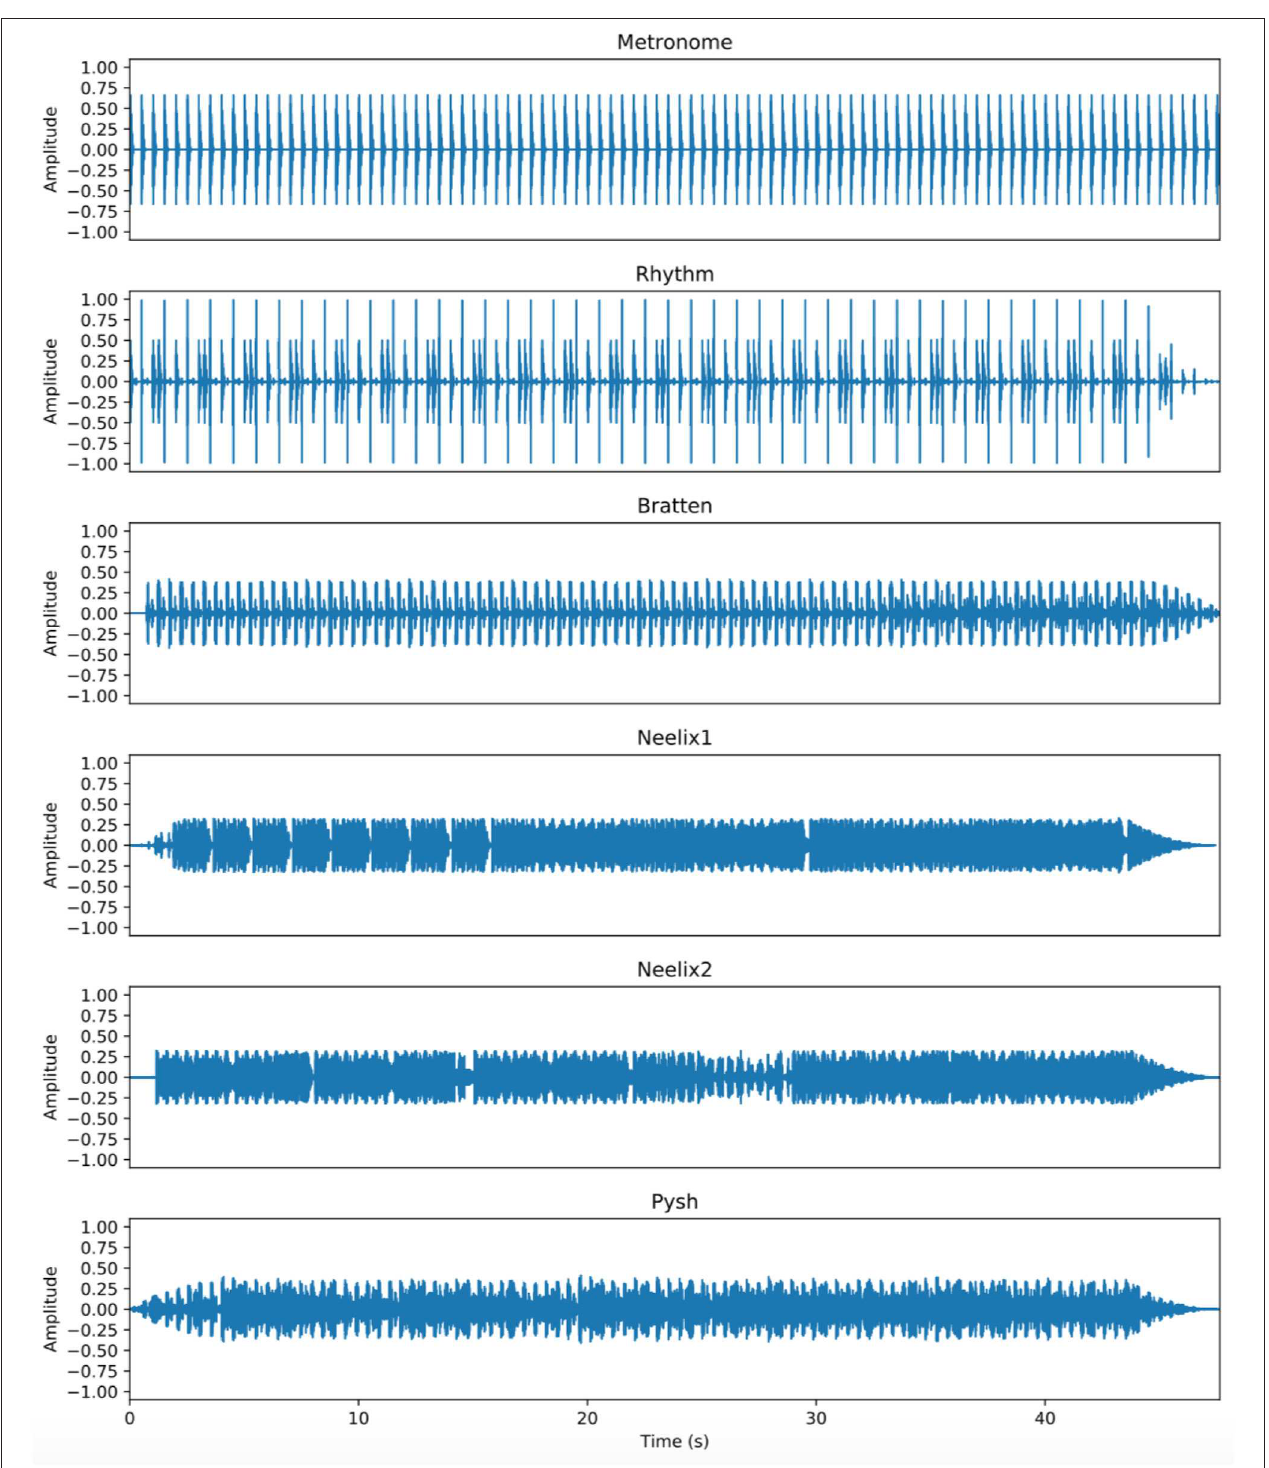
FIGURE 1 | Waveform displays of the six sound stimuli show the increasing level of musical complexity from top to bottom (Metronome = low complexity, Pysh = high complexity). The amplitude peaks of the Metronome and Rhythm tracks are higher than those of the four EDM tracks, but they contain much less energy between the beats. The tracks were judged to be perceptually similar in loudness (see text for details).